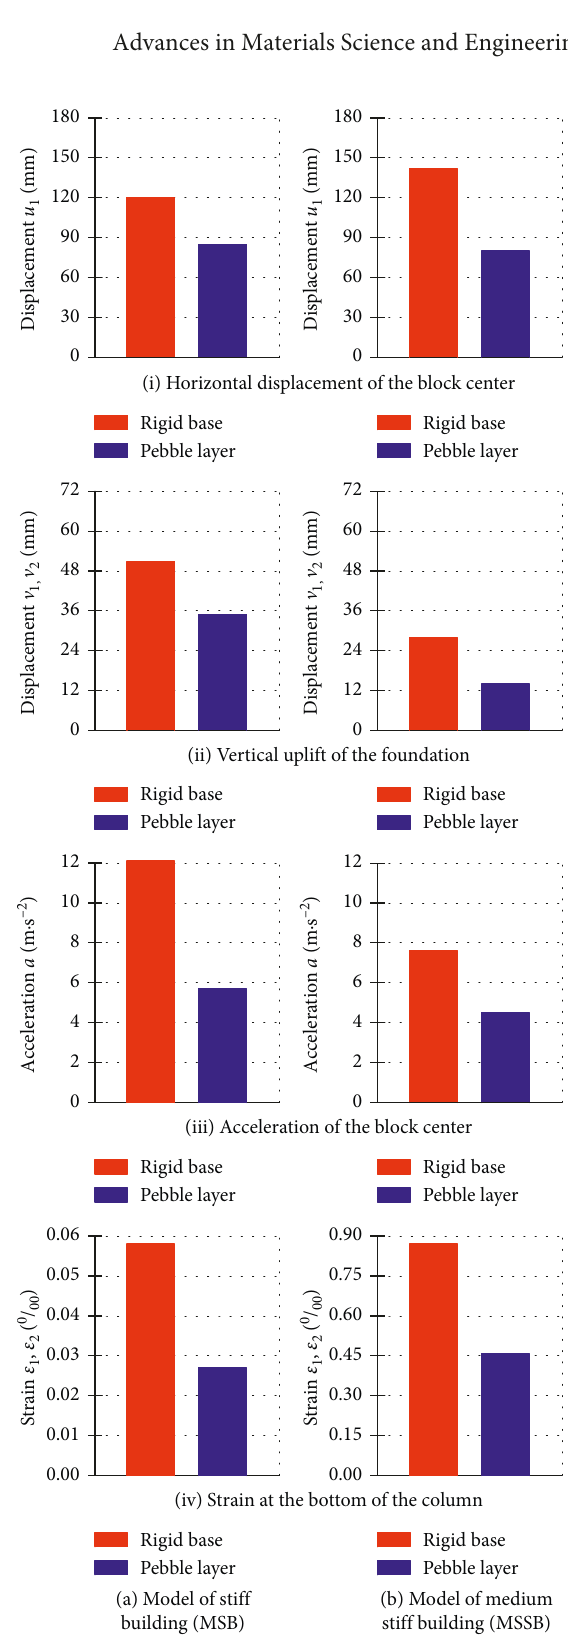
Figure 20: Some maximum measured values for an artificial accelerogram (AA). (a) Model of stiff building (MSB). (b) Model of medium stiff building (MSSB).